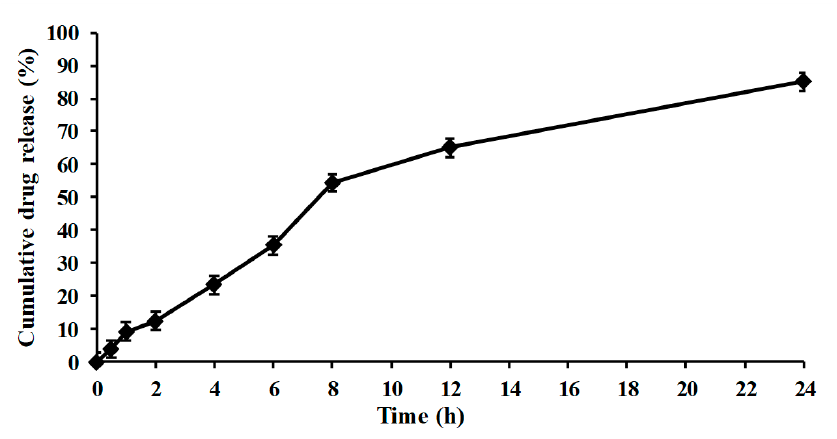
Figure 4. In ‐ vitro release of Capsaicin loaded nanocrystals.